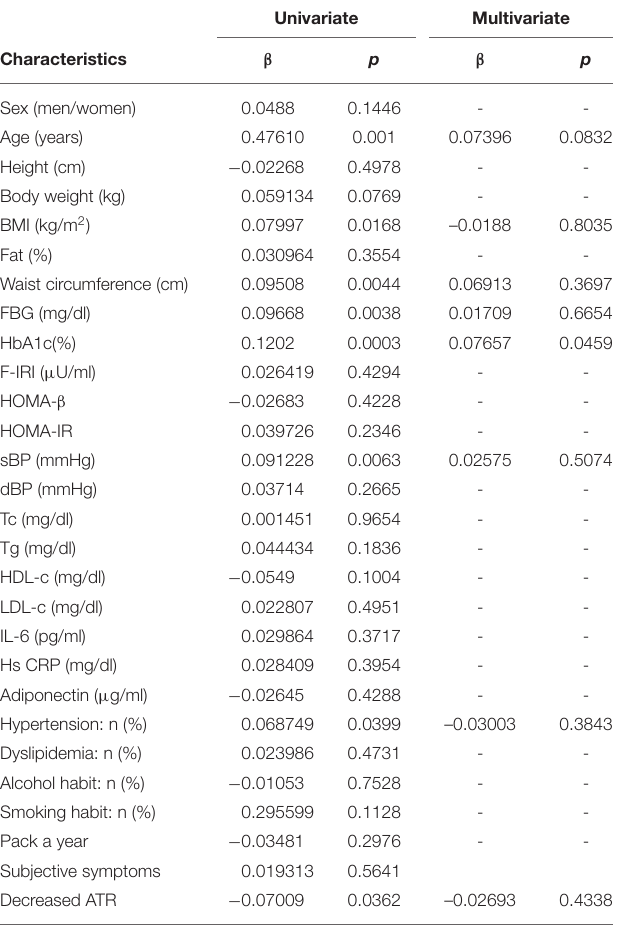
TABLE 3 | Clinical factors correlated with P-IES indices.